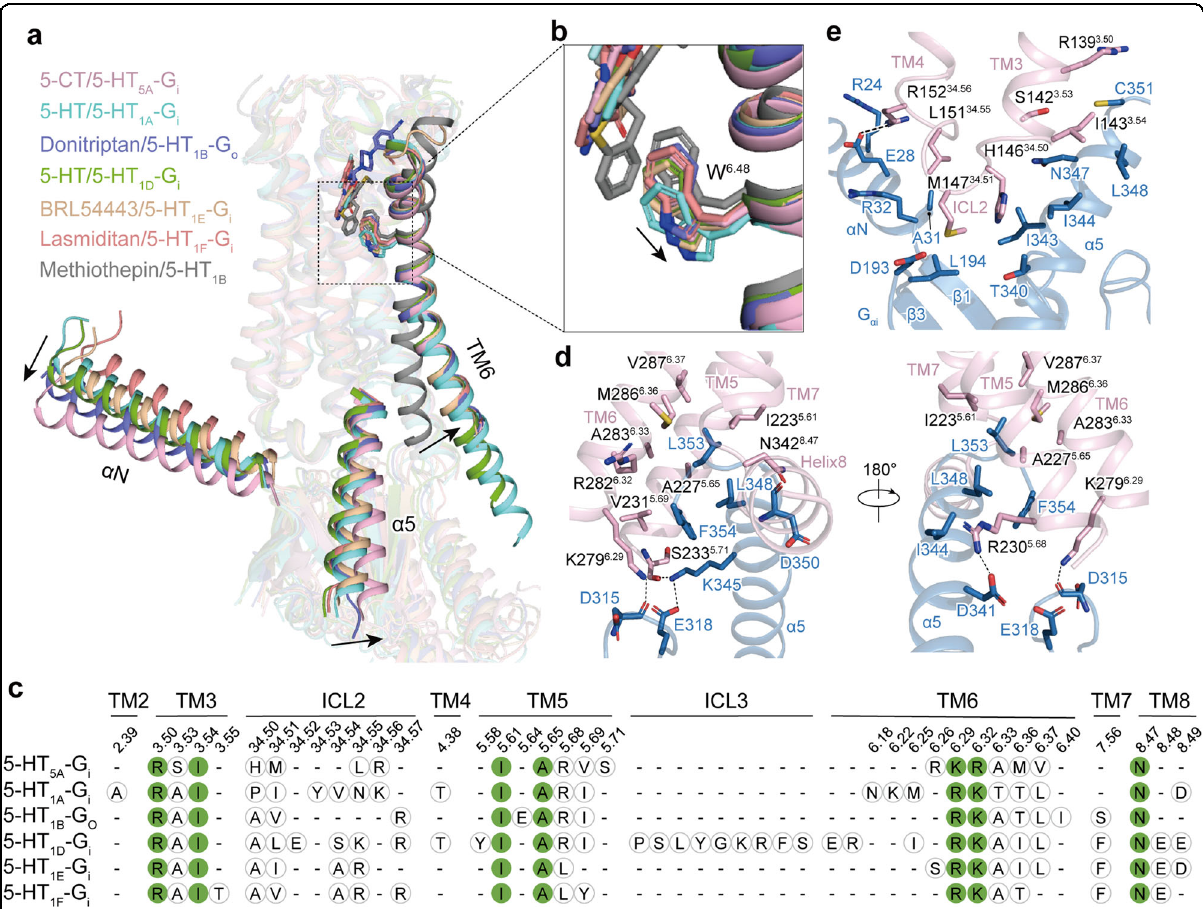
Fig. 4 Structural features of the activation and G i/o coupling of 5-HT 5A and other G i/o -coupled 5-HT receptors. a The activation of 5-HT 5A and other G i/o -coupled 5-HT receptors. The outward movement of TM6 of agonist-bound G i/o -coupled 5-HT receptors compared with methiothepin- bound 5-HT 1B in the inactive state is shown as a black arrow. The movements of the α N and α 5 helix of G α i protein in the 5-HT 5A – G i complex relative to that in other G i/o -coupled 5-HT receptors are indicated as black arrows. The structures of the active 5-HT 5A (light pink), 5-HT 1A (cyan, PDB: 7E2Y), 5-HT 1B (purple, PDB: 6G79), 5-HT 1D (green, PDB: 7E32), 5-HT 1E (wheat, PDB: 7E33), 5-HT 1F (coral, PBD: 7EXD) and inactive-state 5-HT 1B (gray, PDB: 4IAQ) complexes were superimposed based on TM2, TM3 and TM4. b Structural comparison of ligands and the W 6.48 residues of active 5-HT receptors with that of inactive 5-HT 1B . Ligands directly contact W 6.48 . Compared with methiothepin, the inverse agonist of 5-HT 1B , agonists trigger the rotameric switch of W 6.48 , which leads to the outward movement of TM6. c The sequence alignment of receptor residues at receptor – G i/o protein interfaces. The conserved residues are highlighted in solid green circles. d , e Detailed interactions between 5-HT 5A and the G α i subunit. Detailed Interactions between TM5, TM6, and the TM7 – helix 8 junction of 5-HT 5A and the α 5 helix of the G α i subunit ( d ). Detailed interactions between ICL2 of 5-HT 5A and the α 5 and α N helices, β 1 and β 3 strands of the G α i subunit ( e